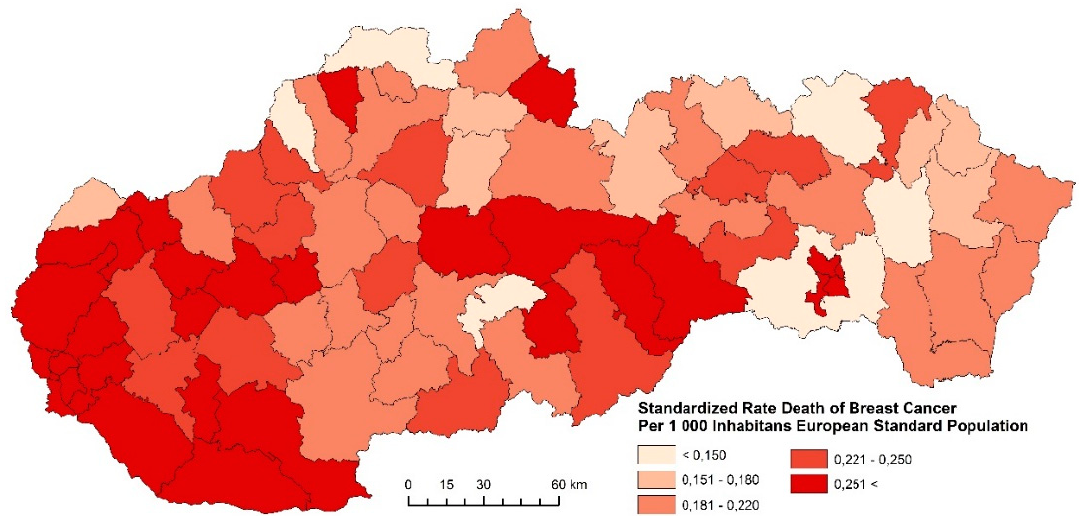
Figure 7. Final statistics and Moran ′ s diagram for standardized death rate of breast cancer per 1000 inhabitants of European Standard Population, 2013–2018. Source: Statistical Office of the Slovak Republic, 2019.